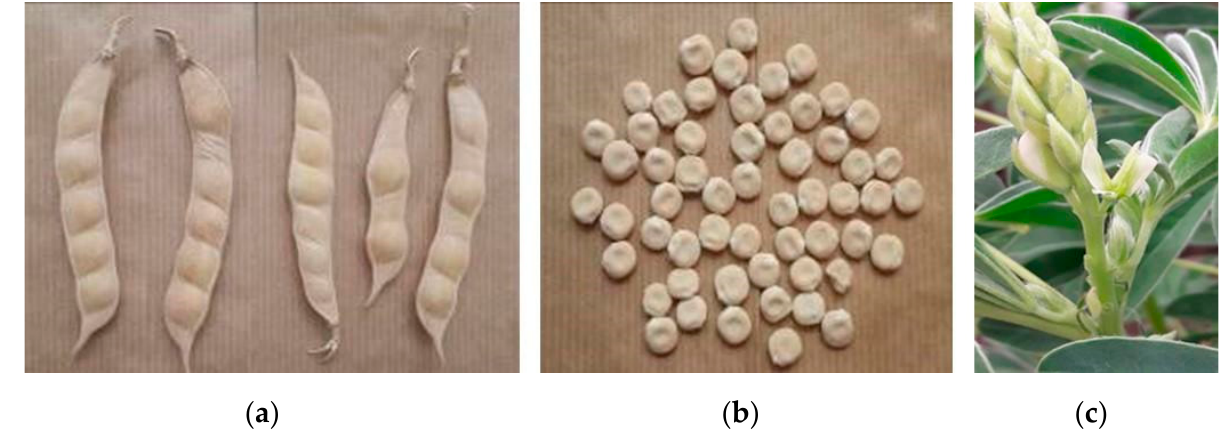
Figure 1. ( a ) Size of pods and number of seeds per pod; ( b ) number and weight of 100 seeds and ( c ) suitable stage of chlorophyll content (SPAD) measurement.